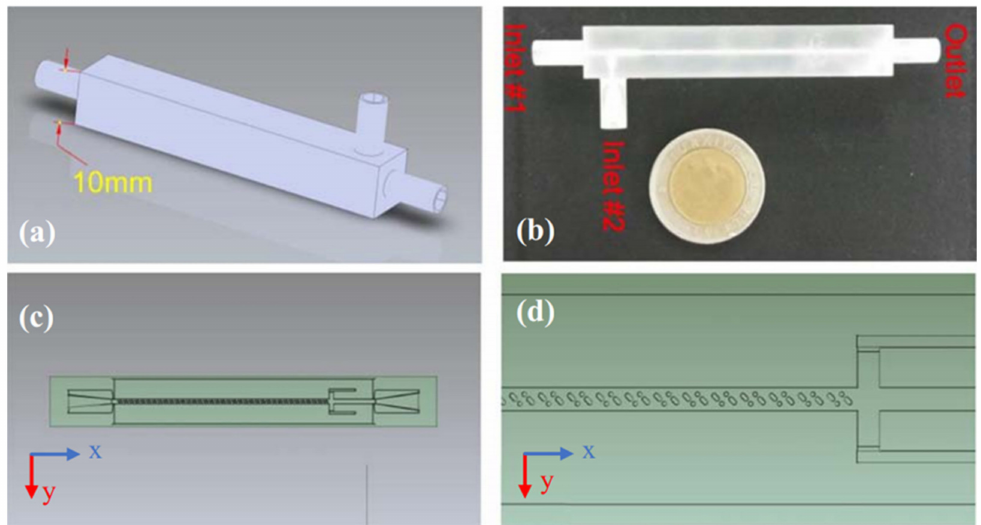
Figure 2. A 3D printed microfluidic chip for magnetic nanoparticle synthesis based on co- precipitation. ( a ) A 3D schematic of the model. ( b ) The 3D printed device. ( c ) The microfluidic channels. ( d ) The hurdles in the channel. Reprinted with permission from M. D. A¸sık et al., 2021 Journal of Nanoparticle Research. 23 62 [31]. Copyright 2021 Springer